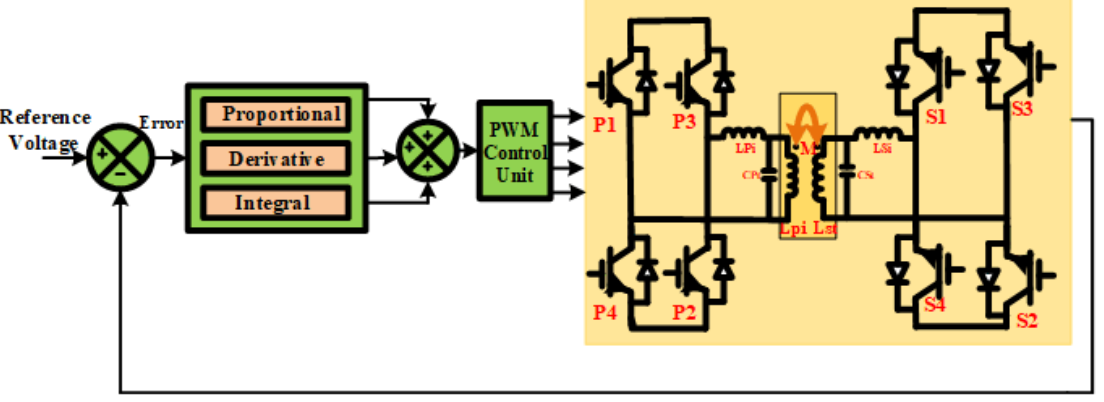
Figure 8. Proportional–Integral–Derivative (PID) controller-interfaced BWPT